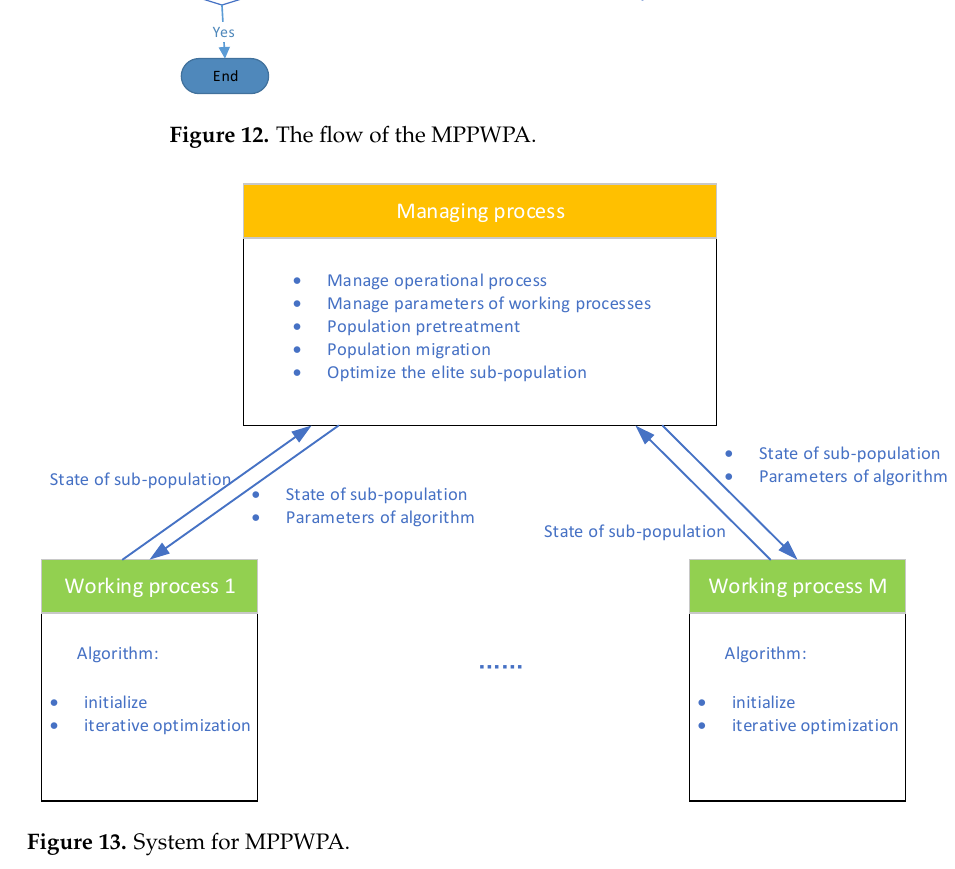
Figure 12. The flow of the MPPWPA.